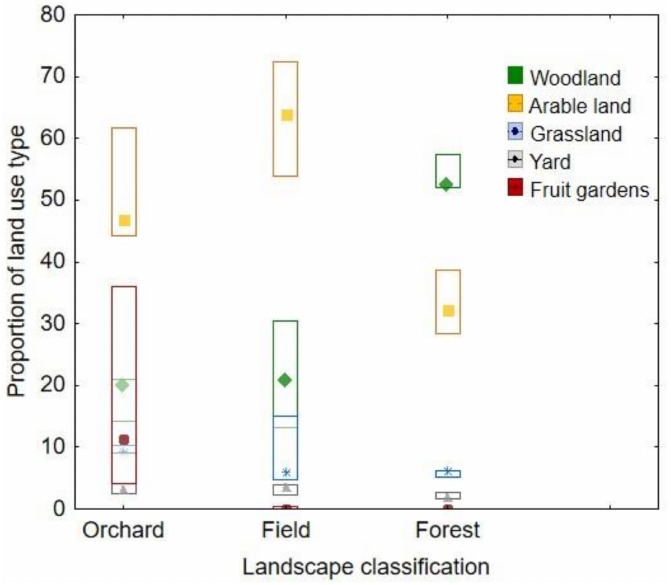
Figure 2. The share of land-use types (woodland, arable land, grassland, yards and fruit gar- dens) across the three land-use categories (Orchard, Field and Forest) within a radius of 1000 m around